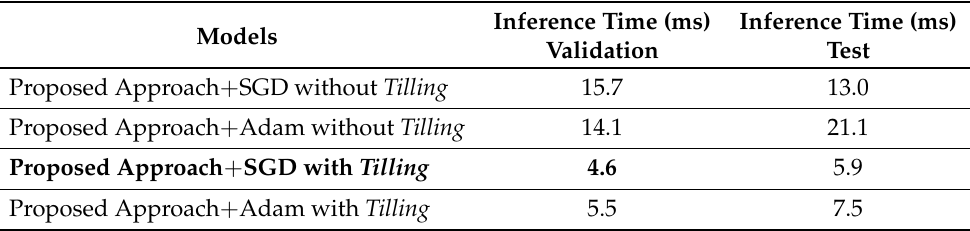
Table 9. Mean inference time to detect fundus lesions per image in the Dataset for Diabetic Retinopa- thy (DDR) in the Validation and Testing stages of the proposed approach.